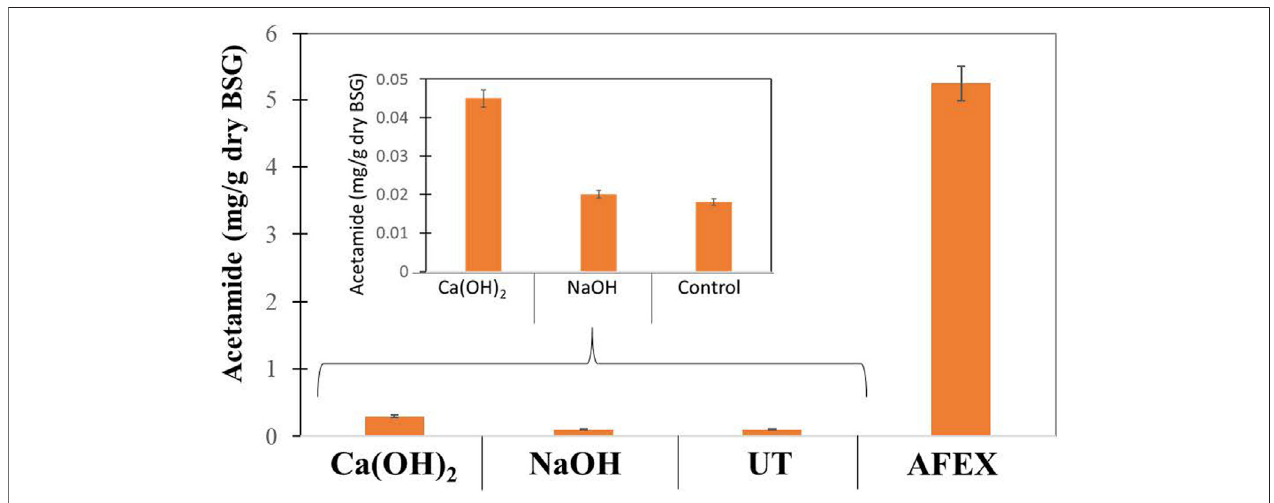
FIGURE 6 | Amount of acetamide (mg/g dry weight) produced in untreated (UT) DDGS, AFEX pretreated DDGS, and two different alkalies [NaOH and Ca(OH) 2 ] treated de-esteri fi ed DDGS followed by AFEX pretreatment. About 10% solids loading and 4% alkali concentration were used during de-esteri fi cation of DDGS prior to AFEX pretreatment. Error bars represent the standard deviation of two replicated experimental